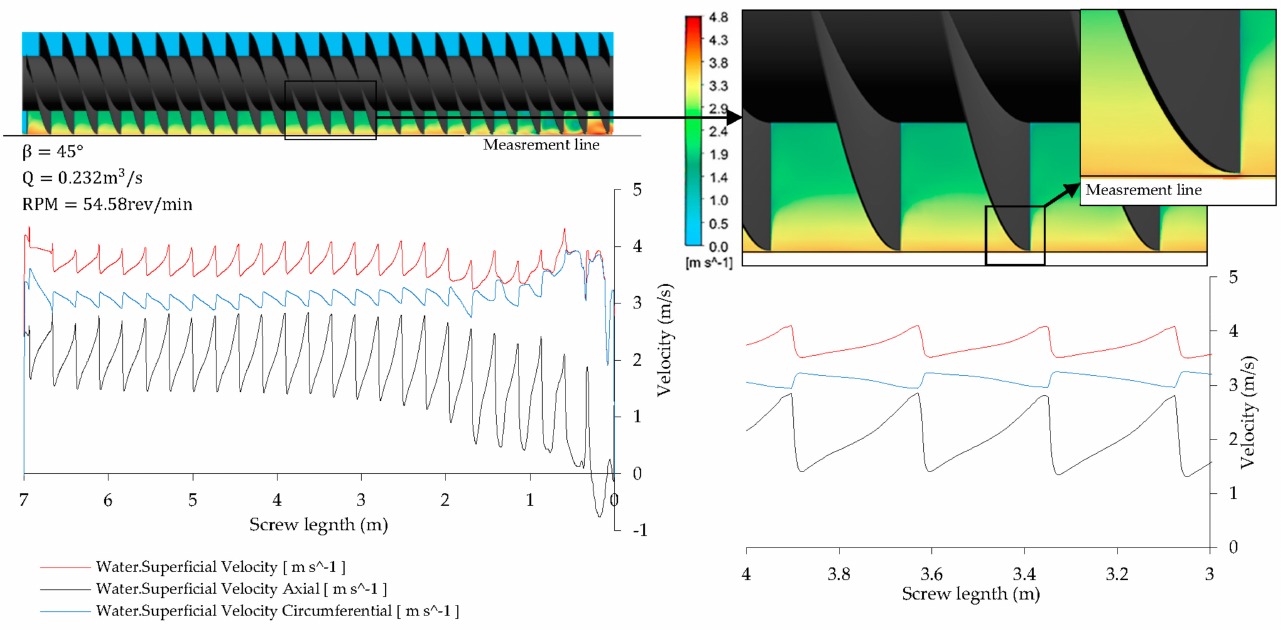
Figure 14. Water superficial velocity variation along the screw